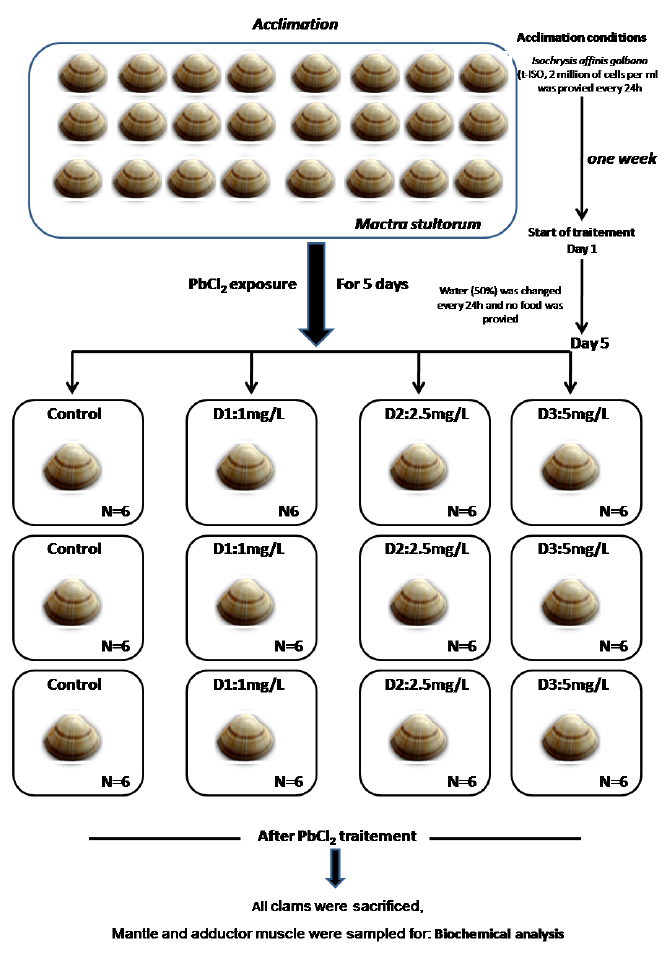
Figure 1. Experimental conception of Mactra stultorum exposed to graded doses of lead chloride (PbCl 2